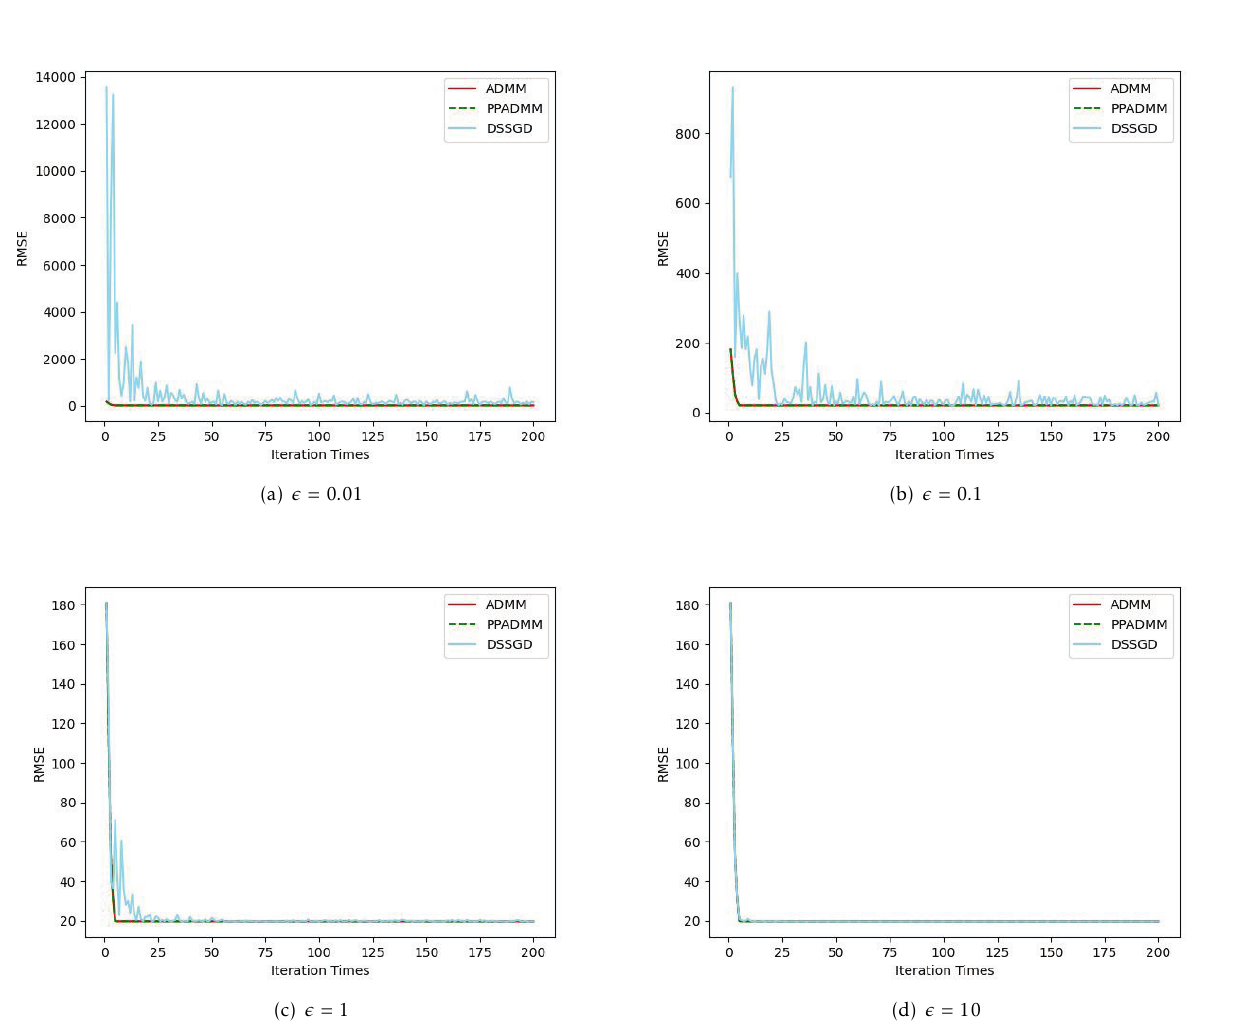
Figure 3. Relationship between RMSE and the number of iteration of ADMM, PPADMM, and